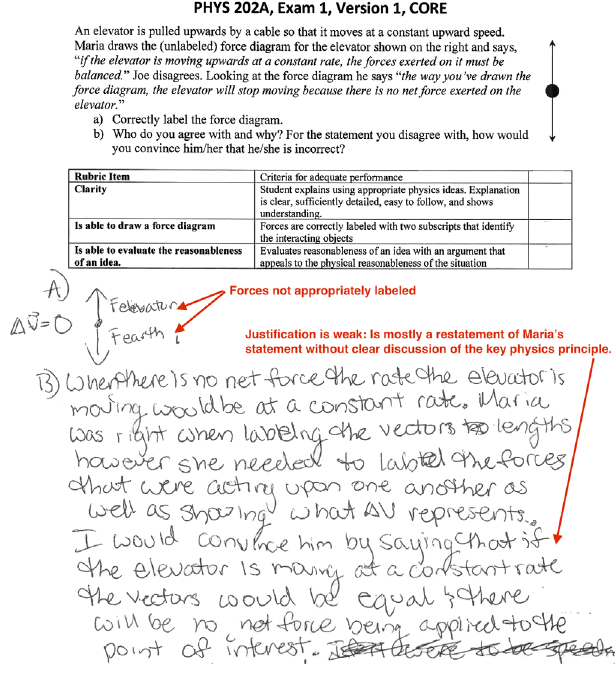
FIG. 9. Student ’ s first attempt at force and motion and evaluation scientific abilities cluster.